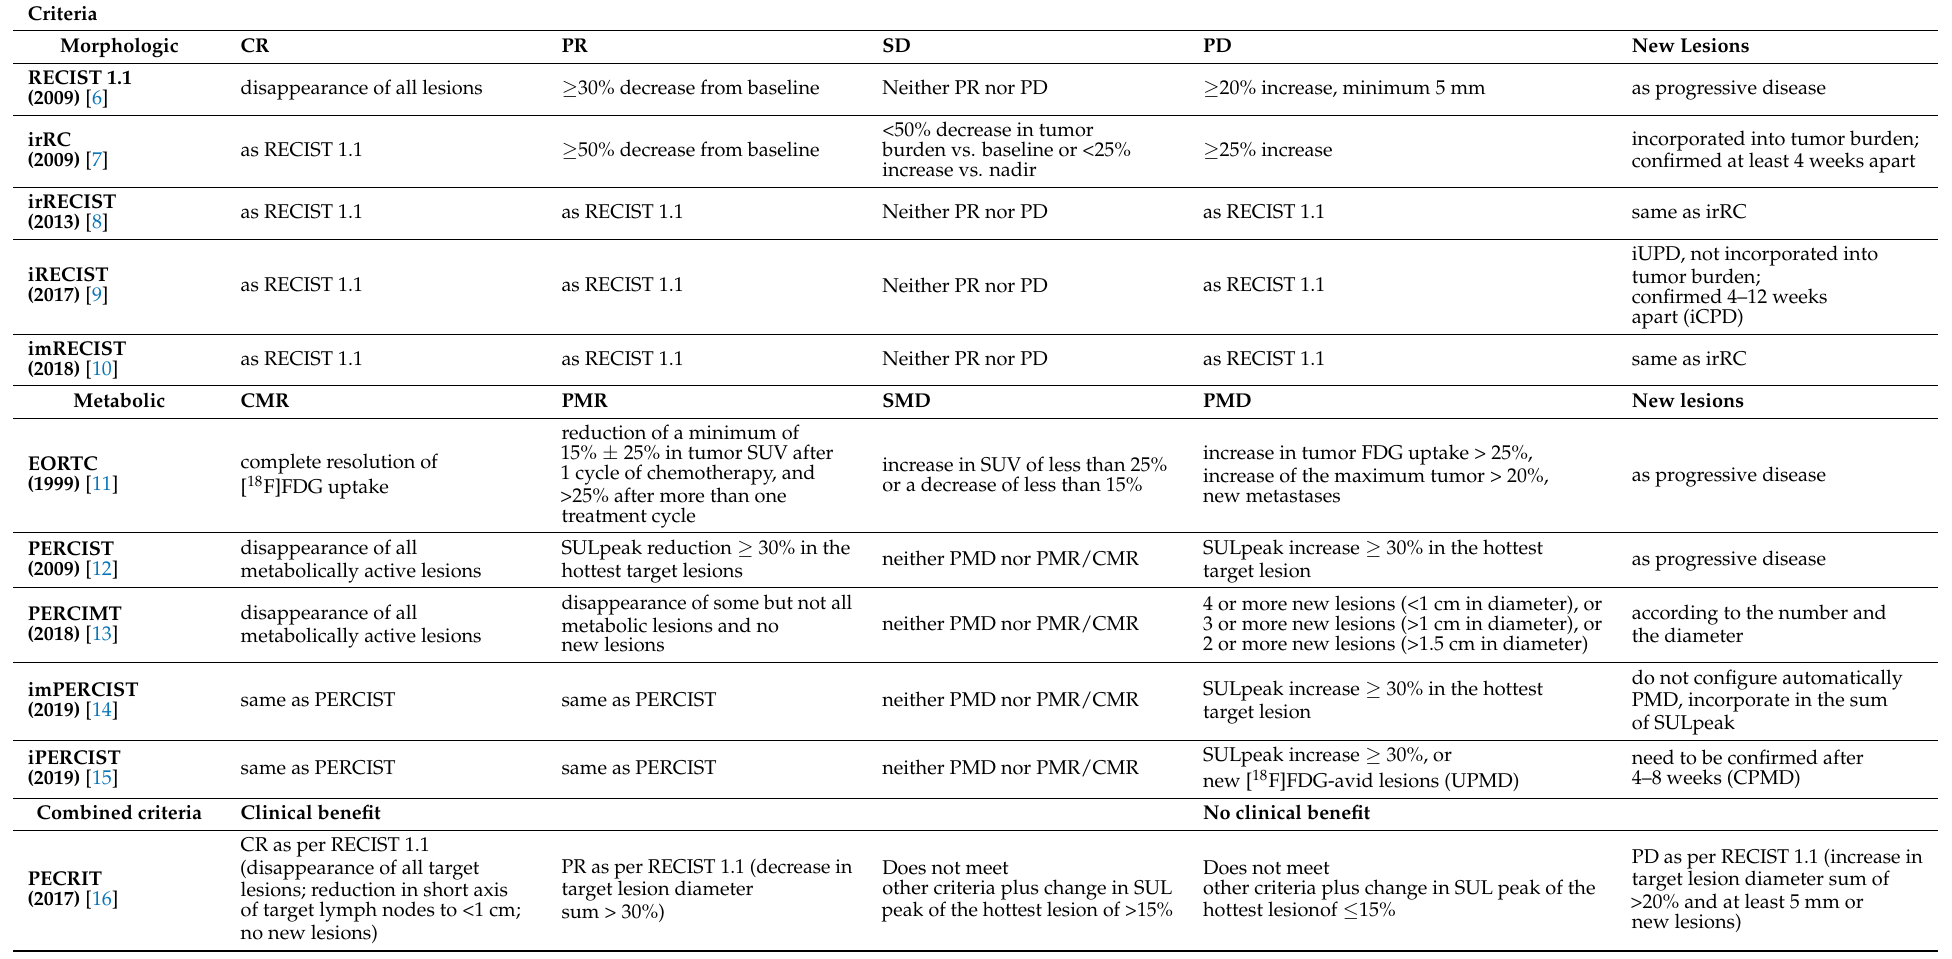
Table 1. Summary of anatomic and metabolic criteria for immunotherapy response